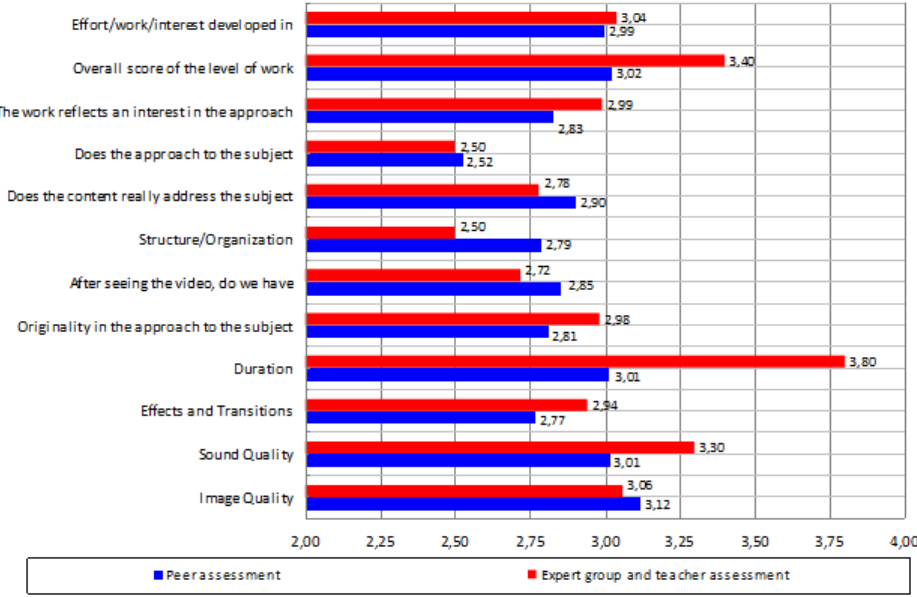
Fig. 1. Results obtained, on a maximum score of five points, for the different aspects assessed by the expert group and the teacher and the students